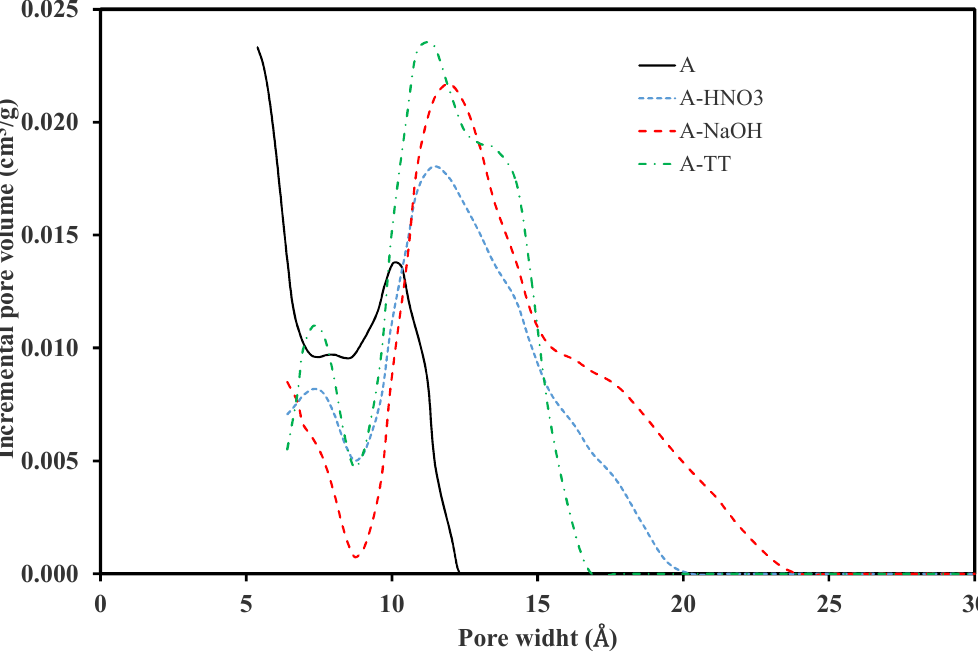
Figure 4. Pore size distribution of the different ACs estimated by nonlocal density functional theory (NLDFT) method.